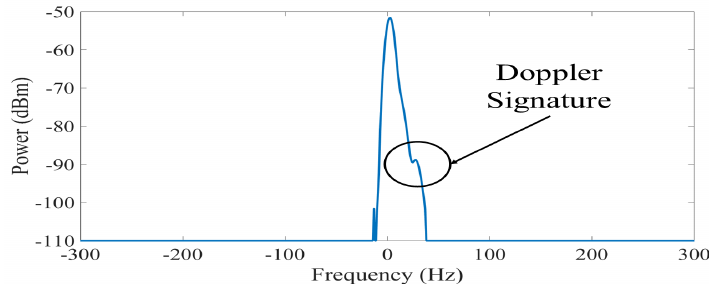
Figure 4. Snapshot of the probe signal during a falling event without applying a pre-processing stage.